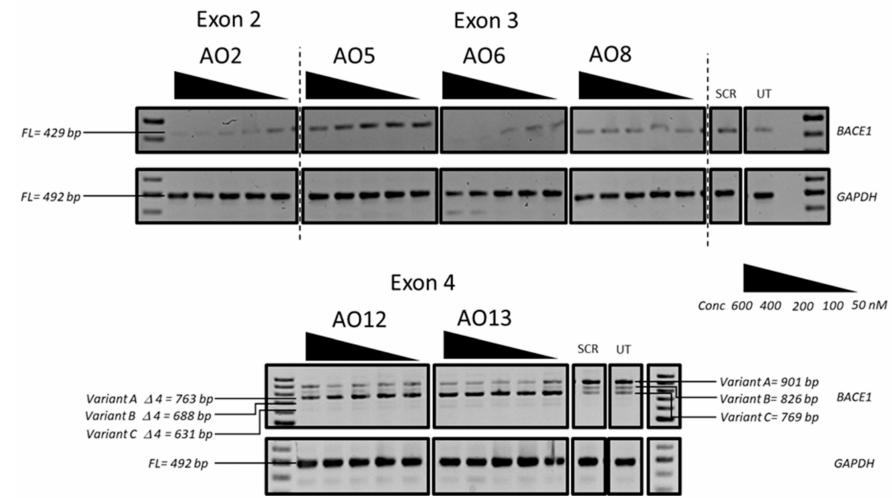
Figure 2. RT-PCR analysis of the BACE1 and GAPDH transcripts after treatment with the best working 2’-O-MePS AOs (AO2, AO5, AO6, AO8, AO12, and AO13) targeting exons 2, 3, and 4 at 600 nM, 400 nM, 200 nM, 100 nM, and 50 nM concentrations in HEK293 cells. FL, full-length; UT, untreated; SCR, scrambled sequence; GAPDH was used as a loading control. The gel images were cropped to highlight the BACE1 -specific products and the corresponding house-keeping gene control GAPDH . The original images are shown in Figure S3 (Supplementary Information).